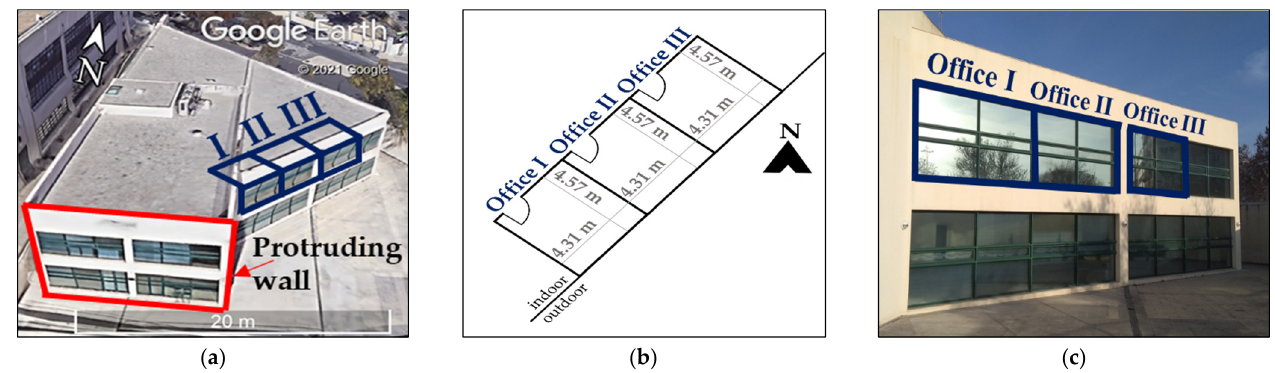
Figure 3. Office rooms used as case study: ( a ) identification in dark blue of the location of the three office rooms in the university building (Google Earth 2021); ( b ) dimensions (length and width) of the office rooms; ( c ) location (in dark blue) of the glazing systems of the office rooms on the exterior façade (oriented southeast).